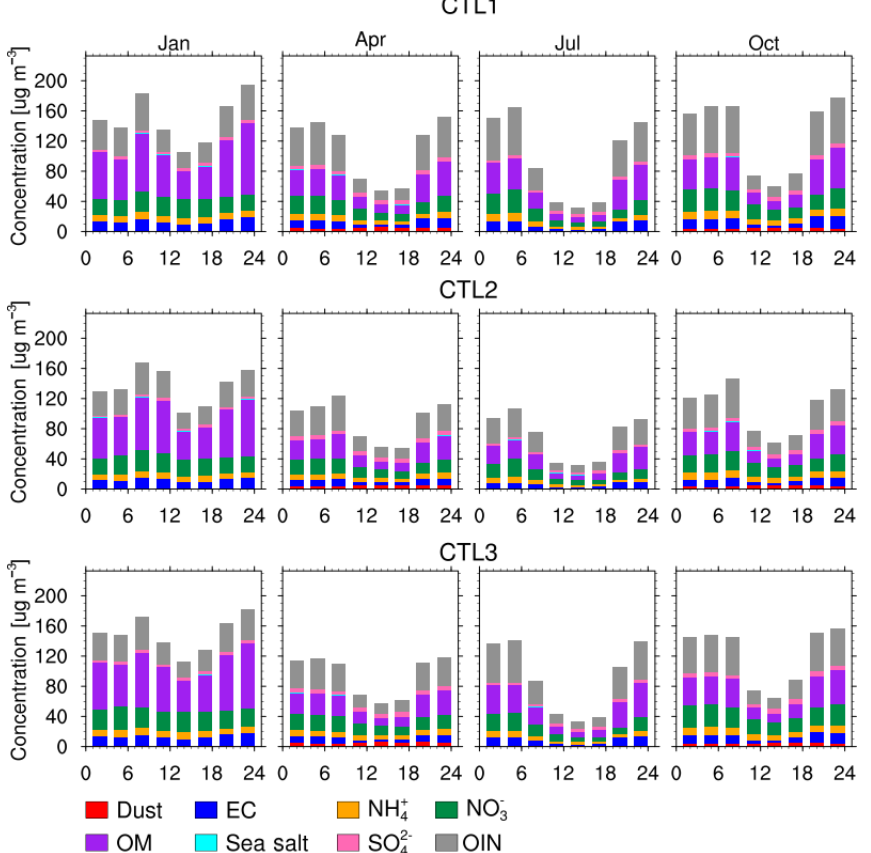
Figure 5. Diurnal variation of surface concentrations of each PM 2 . 5 composition (dust, OM, EC, sea salt, NH + inorganics) averaged over Hefei for January, April, July, and October of 2018 from experiments CTL1, CTL2, and